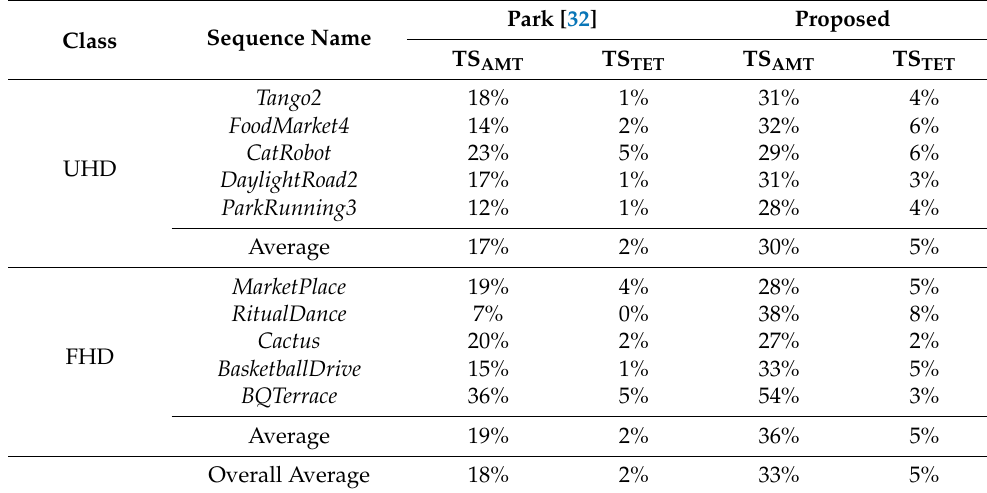
Table 4. Time saving between the proposed and previous method [32] on top of VTM 10.0.